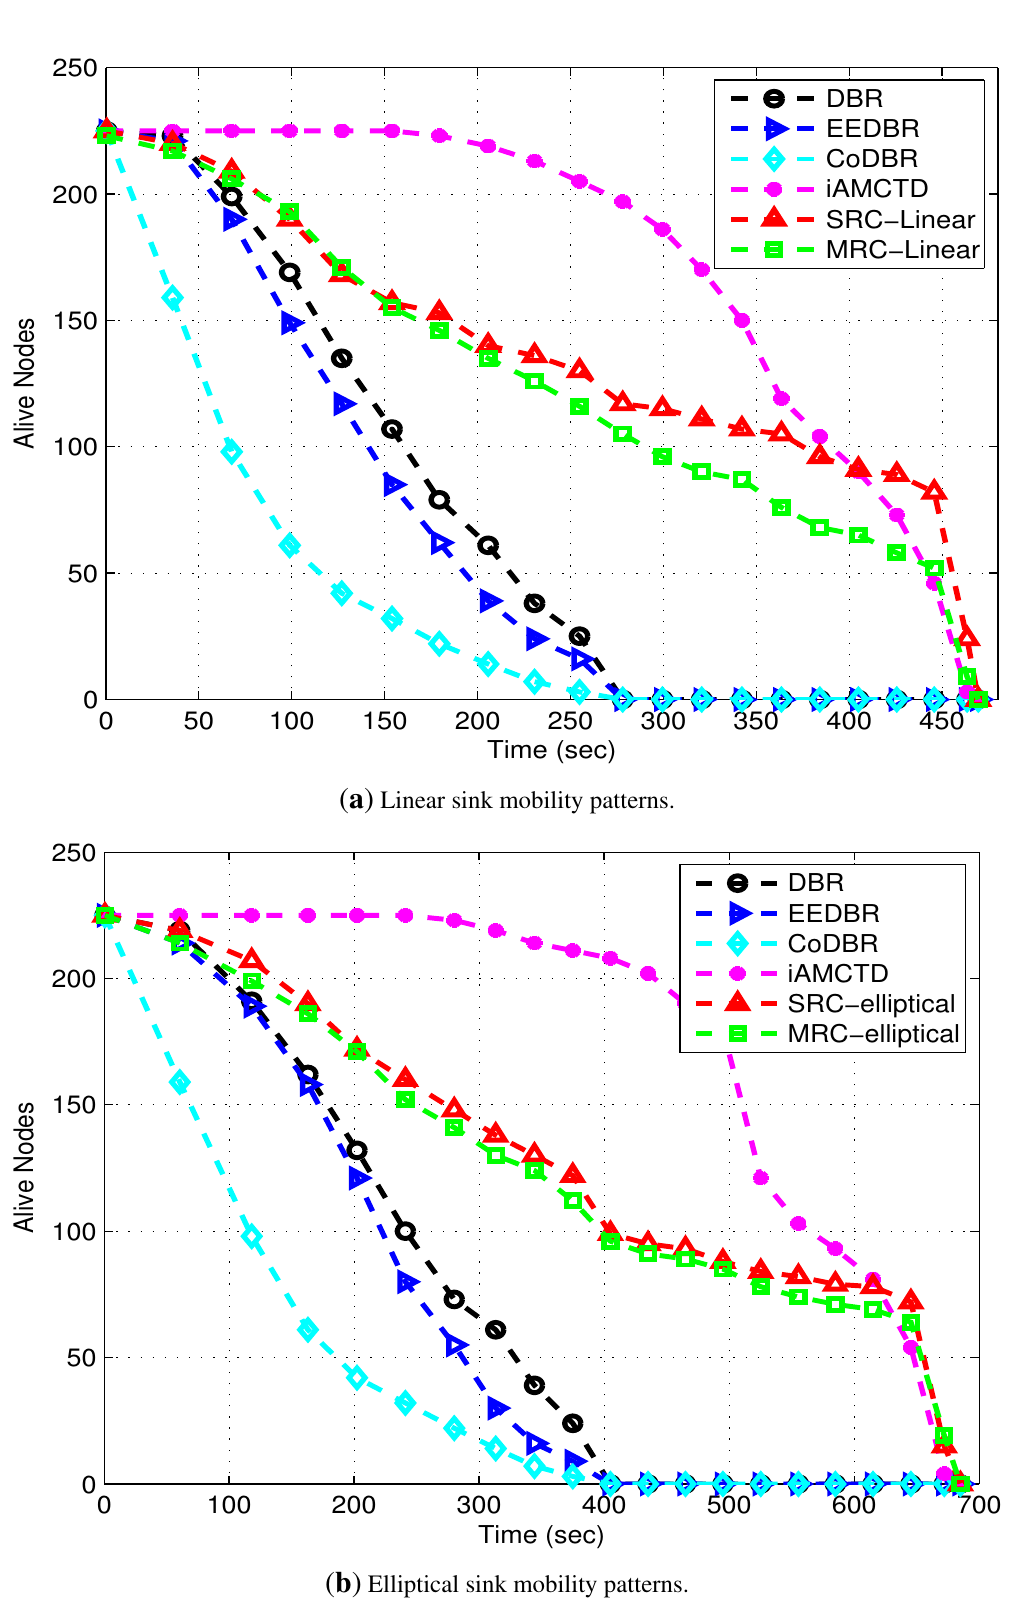
Figure 10. Lifetime with linear and elliptical sink mobility